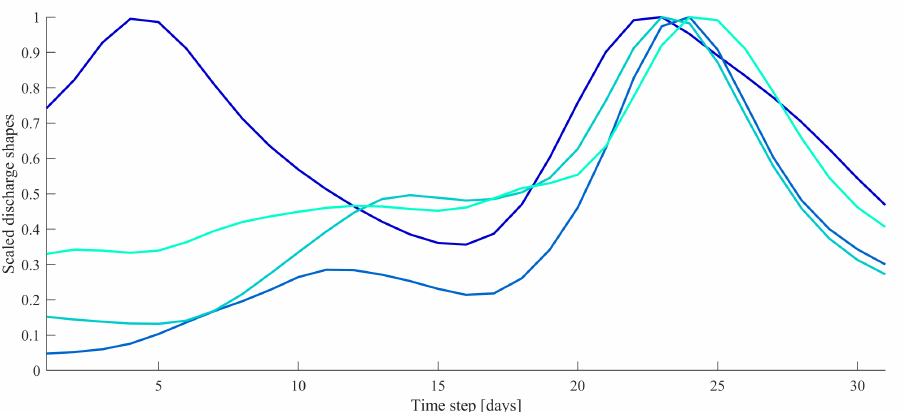
Figure 4. Different normalized discharge waves that are used to get realistic potential flood events by multiplying these discharge wave shapes with the sampled peak